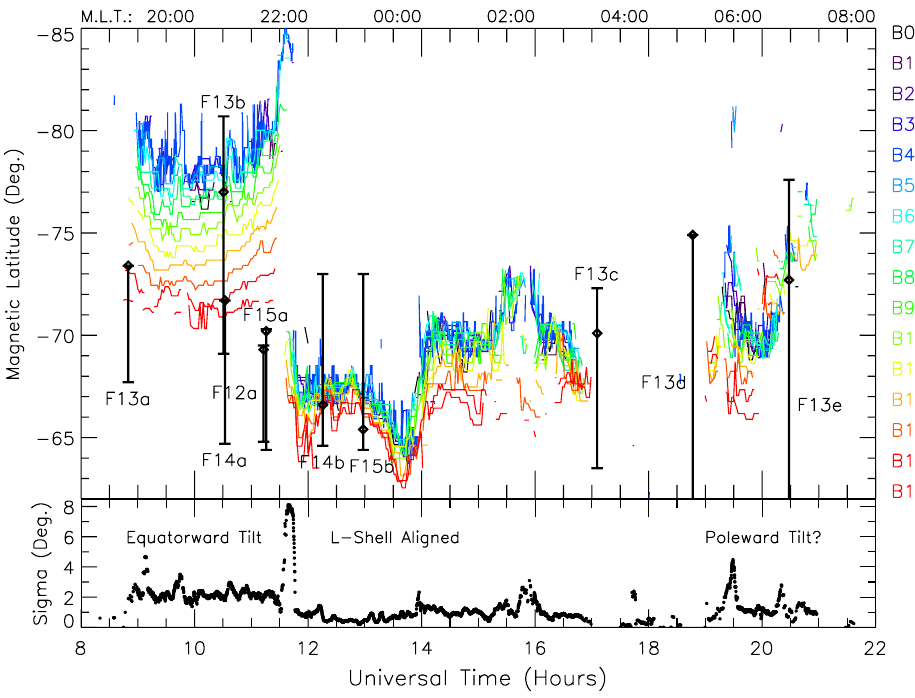
Fig. 7. (a) Magnetic latitude vs. UT plot of the radar SWB identified on all 16 beams of the TIGER radar during 08:00 to 22:00 UT, 1 April 2000. The SWB on each beam is colour coded (right) using black for beam 0, violet for beam 1, ... , and red for beam 15. The 10 bold, vertical bars with diamonds represent the location of the auroral oval identified from spectrograms of precipitating particles measured on board the DMSP satellites (symbols explained in the text). (b) The standard deviation of the SWB identified on all 16 beams using a running time window of 192s (two full